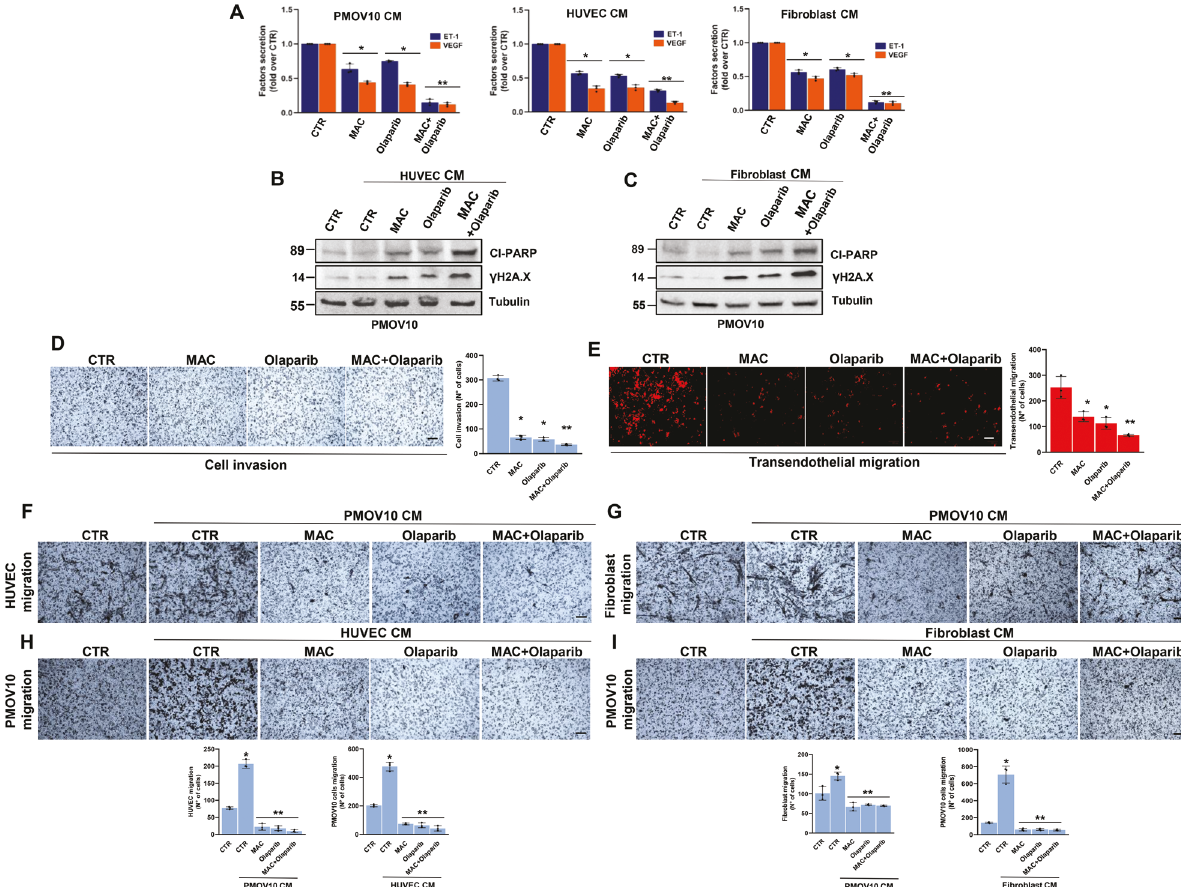
Fig. 7 The combination of macitentan and olaparib, impairing the p53/YAP/HIF-1 α -mediated release of ET-1 and VEGF, interferes with tumor/stroma signal reciprocity and the pro-invasive behavior of HG-SOC cells. A ELISA for ET-1 and VEGF released by PMOV10 cells, HUVEC and fi broblasts treated with macitentan or olaparib, alone or in combination for 24 h. Bars are the means ± SD (* p < 0,002 vs. CTR; ** p < 0,0006 vs. olaparib; n = 3). B , C IB analysis of cl-PARP and γ H2A.X expression in PMOV10 cells treated with CM from HUVEC ( B ) or fi broblasts ( C ) prestimulated with MAC or olaparib, alone or in combination for 24 h. Tubulin represents the loading control. Representative images of blots of 3 independent experiments are shown. D Invasion assay of PMOV10 cells treated with MAC or olaparib, alone or in combination for 24 h. Representative images of the invading cells were photographed (scale bar: 100 µm, magni fi cation 20X) ( left panels ) or counted ( right graph ). Bars are the means ± SD (* p < 0.0002 vs. CTR; ** p < 0.02 vs. olaparib-treated cells; n = 3). E Transendothelial migration assay of PMOV10 cells treated with MAC or olaparib, alone or in combination for 24 h. Representative images of the transmigrated cells were photographed (scale bar: 100 µm, magni fi cation 20X) ( left panels ) or counted ( right graph ). Bars are means ± SD (* p < 0.0002 vs. CTR; ** p < 0.0003 vs. olaparib-treated cells; n = 3). F , G Migration assay of HUVEC (F) or fi broblasts (G) treated with CM from PMOV10 cells prestimulated with MAC or olaparib, alone or in combination for 24 h. Representative images of migrating cells were photographed (scale